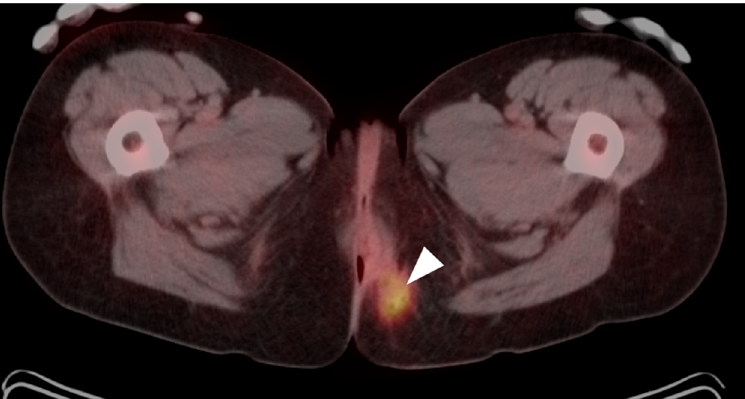
Figure 41. Perianal infection (white arrowhead) is hypermetabolic and can mimic the appearance of an anal cancer, as shown on this axial fused FDG PET-CT of the perineum.